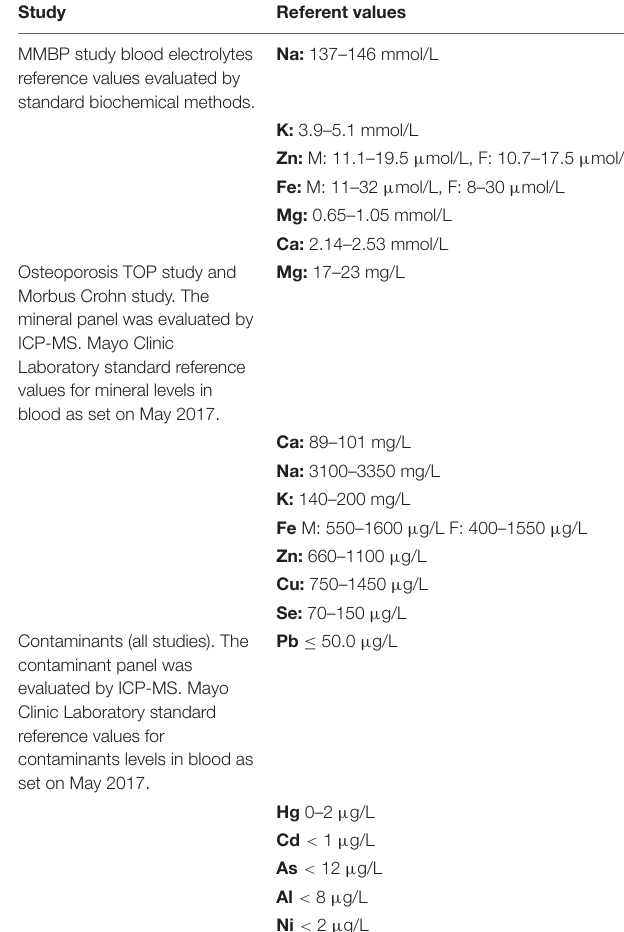
clinical studies.